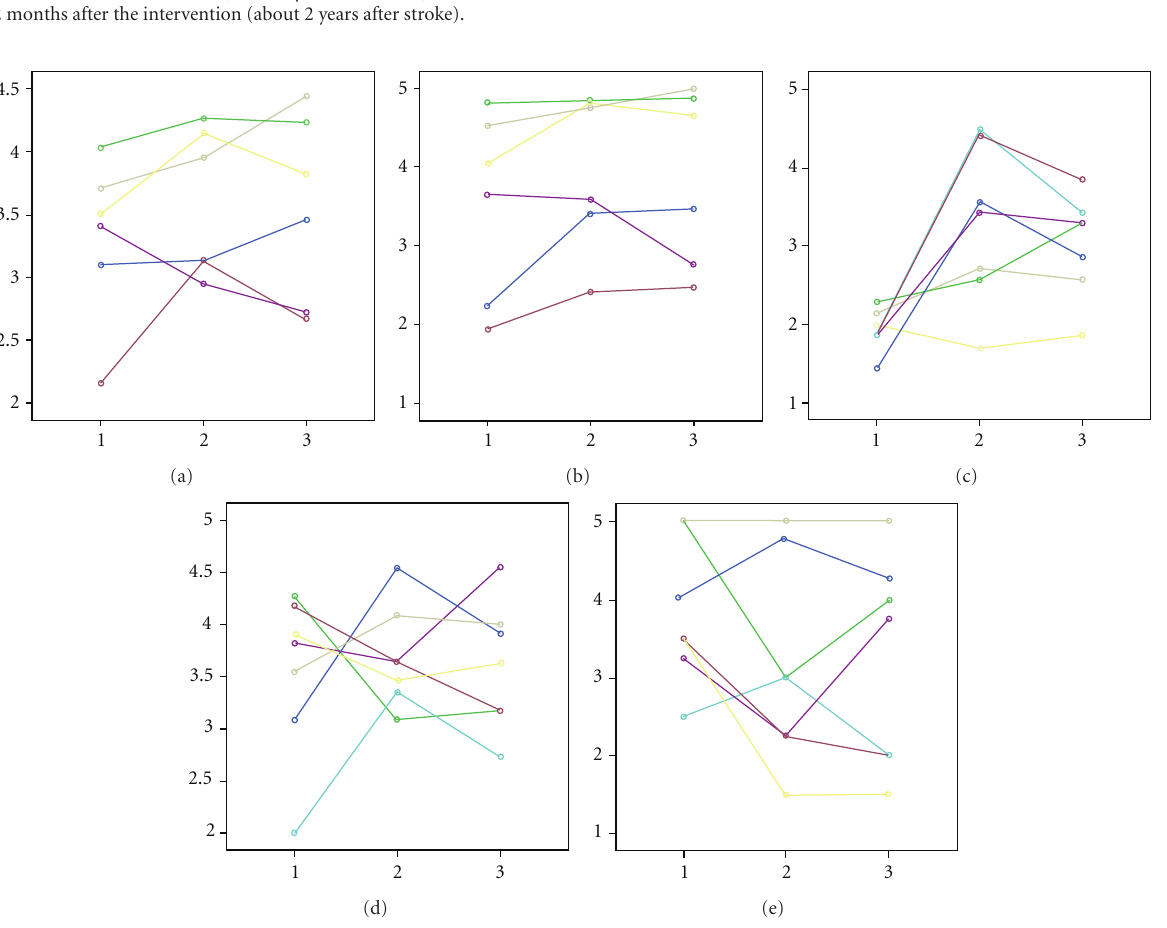
Figure 1: Plot diagrams of the participants’ statements on SAQOL-39. SAQOL-39: Stroke and Aphasia Quality of Life Scale.